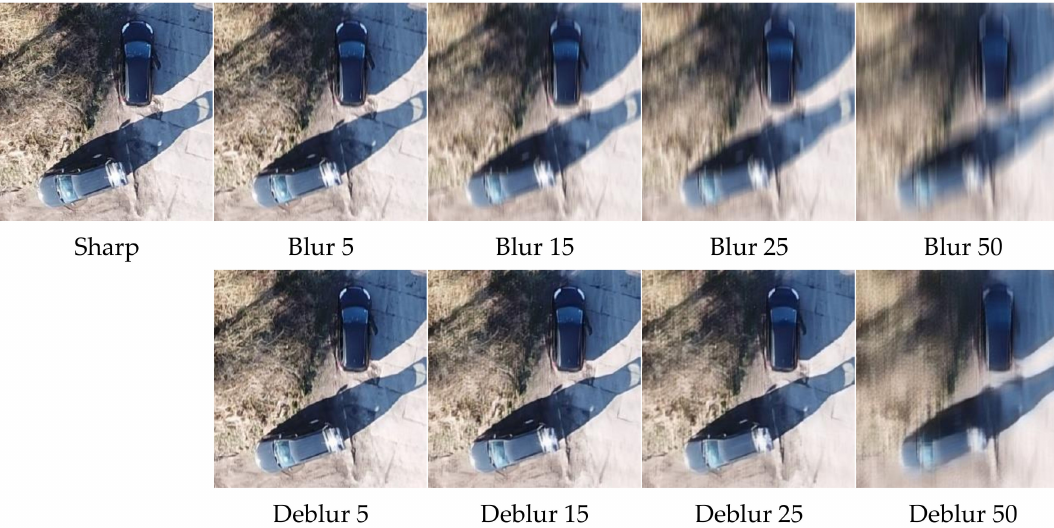
Figure 5. Cars parked within the measurement area—visual comparison of blur with a varying kernel and a corresponding DeblurGANv2 method